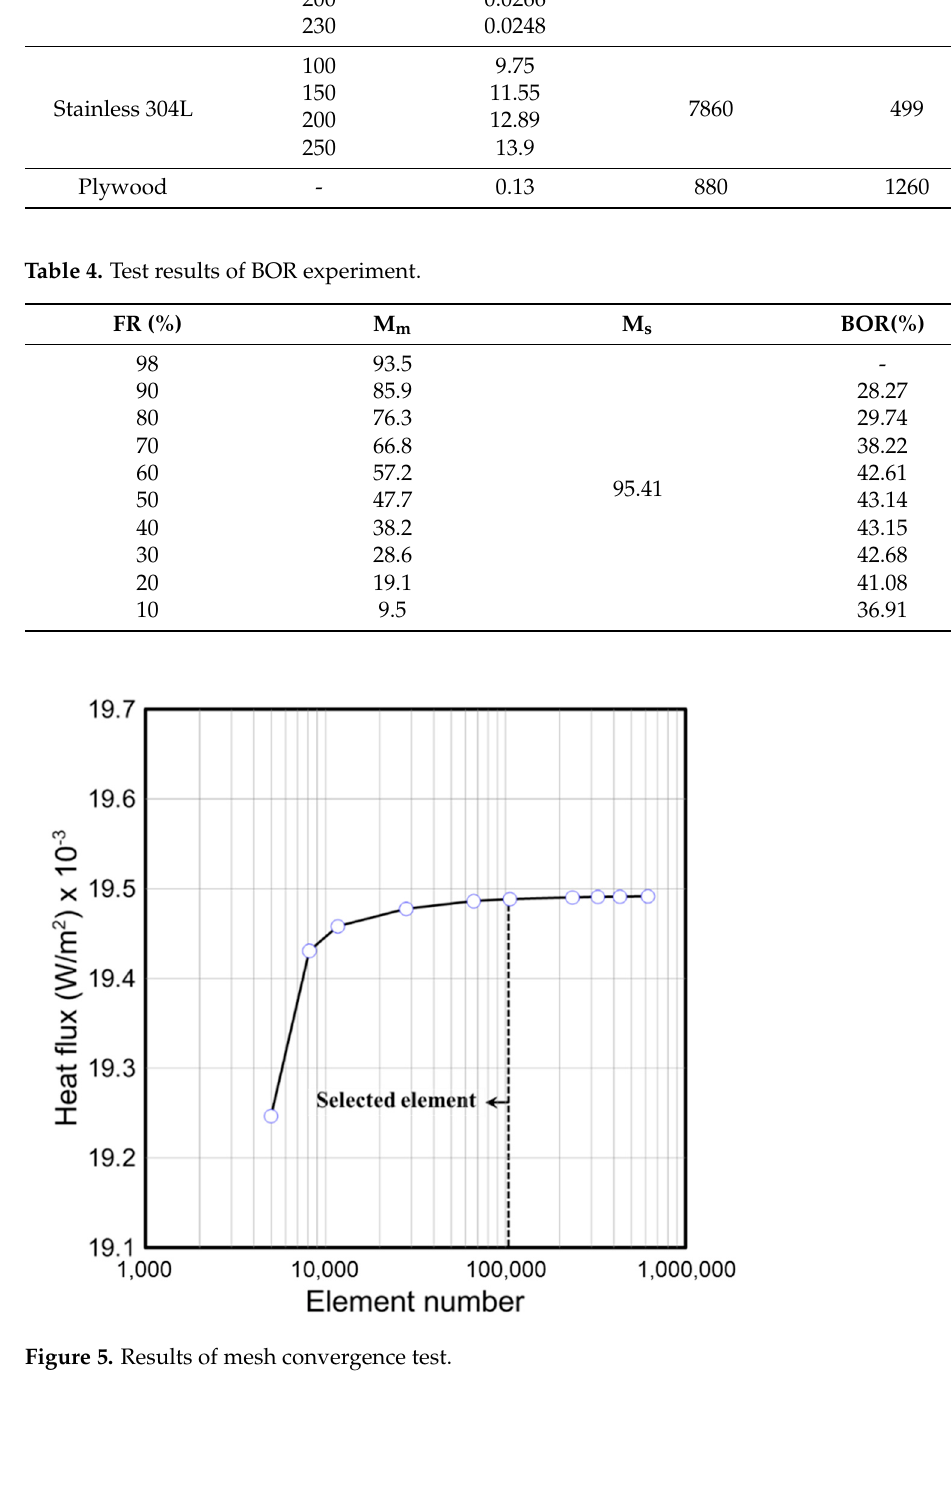
Figure 6. Elements of analysis model.